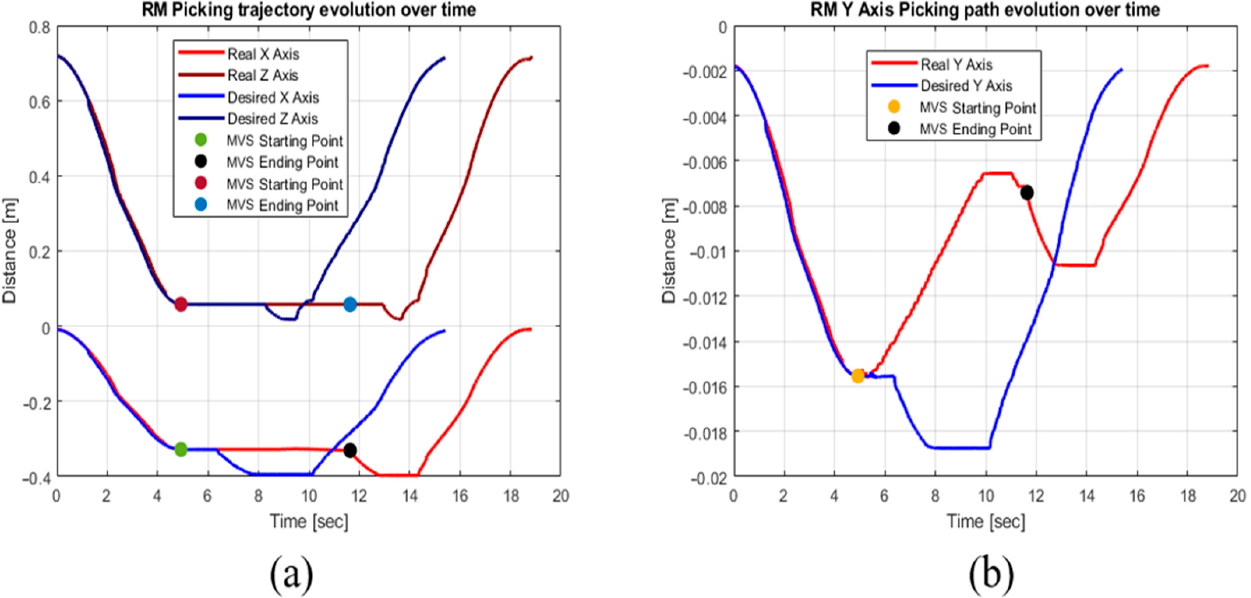
Figure 17. Trajectories evolution over time for ( a ) X and Z axis and ( b ) Y axis for picking the workpiece.